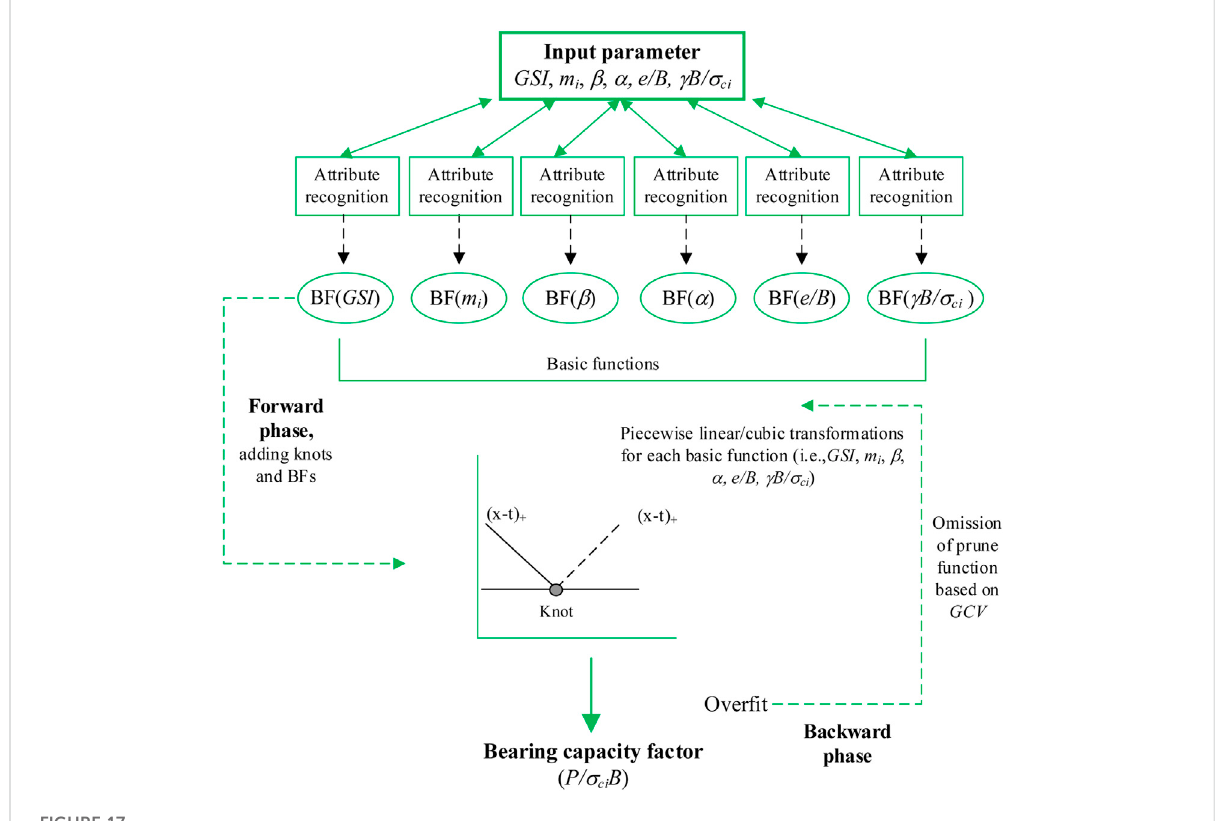
FIGURE 17 MARS algorithm.